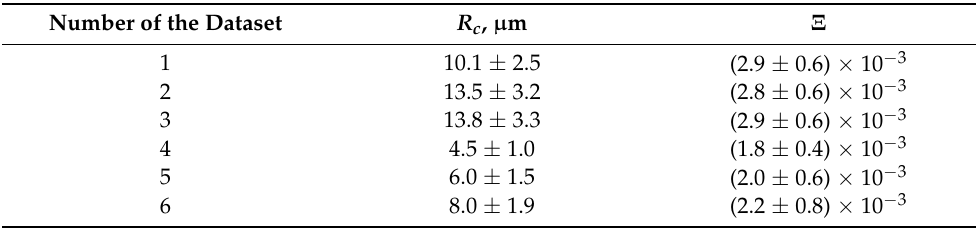
Figure 8. Fitting of the empirical data (Figure 5a) based on the self-similar dependence (s-s) (Figure 7). The assignment of the markers (1–6) corresponds to that accepted for Figures 4 and 5a. Table 3. The fitting parameters ( R c , Ξ ) for the datasets 1–6 (Figure 8).